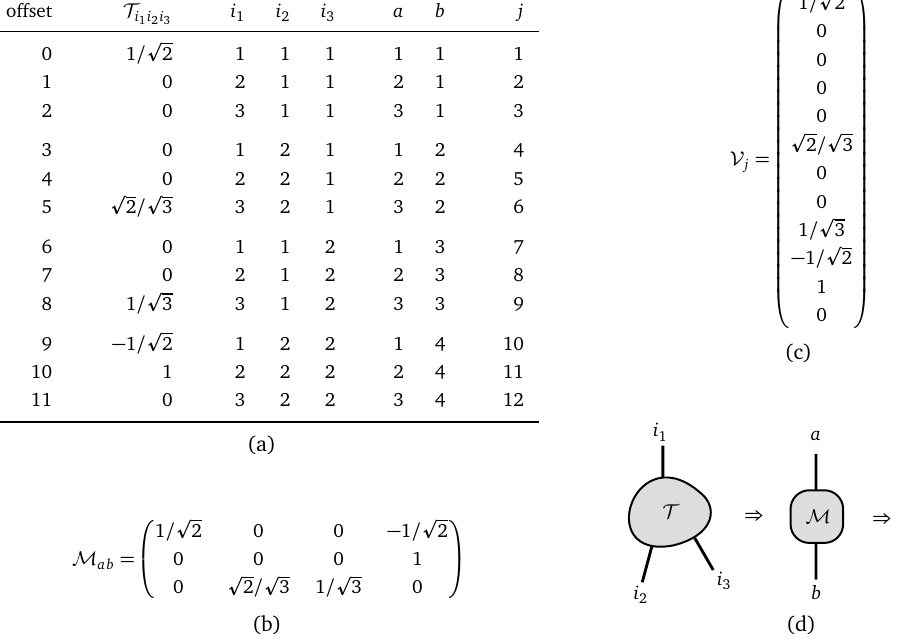
∈ R of dimensions d = 3, Figure 5: Example of a real-valued three-link tensor T i 1 i 2 i 3 1 = d = 2. (a) In the table we list all tensor elements and their indices (in column- d 2 3 major order) using the ordering (offset) from Eq. (5). In the additional columns to the right we also added the respective indices after the tensor is reshaped into a = T matrix and a vector (see fusing in Sec. 2.2.1). (b) The matrix M , has ab i 1 ( i 2 i 3 ) ) of dimensions d = d = 3 and row- and column indices a = i and b = fuse ( i , i a 1 2 3 1 = d = 4. (c) The vector V = T = fuse ( i ) , d d , i , i ( i ) has a combined index j b j 2 3 1 2 3 1 i 2 i 3 = # T = 12. (d) A graphical represen- according to Eq. (8), of total dimension d j tation of the three-link tensor. The tensor T could e.g. encode the three normal- 〉 = (cid:80) | i 〉 , i.e. | Ψ 〉 = 1 / 2 ( | 11 〉 − | 22 〉 ) , | Ψ 〉 = | 22 〉 and T i ized states | Ψ i 1 i 1 i 2 i 3 2 3 1 2 (cid:112) (cid:112) i 2 , i 3 (cid:0) | (cid:1) | Ψ 〉 = 1 / 3 21 〉 + 2 | 12 〉 , spanning a subspace in the two-qubit Hilbert space 3 {| i 〉} . Their expansions can be read from the rows of M , with columns corre- , i 2 3 ) = ( 1,1 ) , ( 2,1 ) , ( 1,2 ) , ( 2,2 ) from left to sponding to ( i , i 2 3